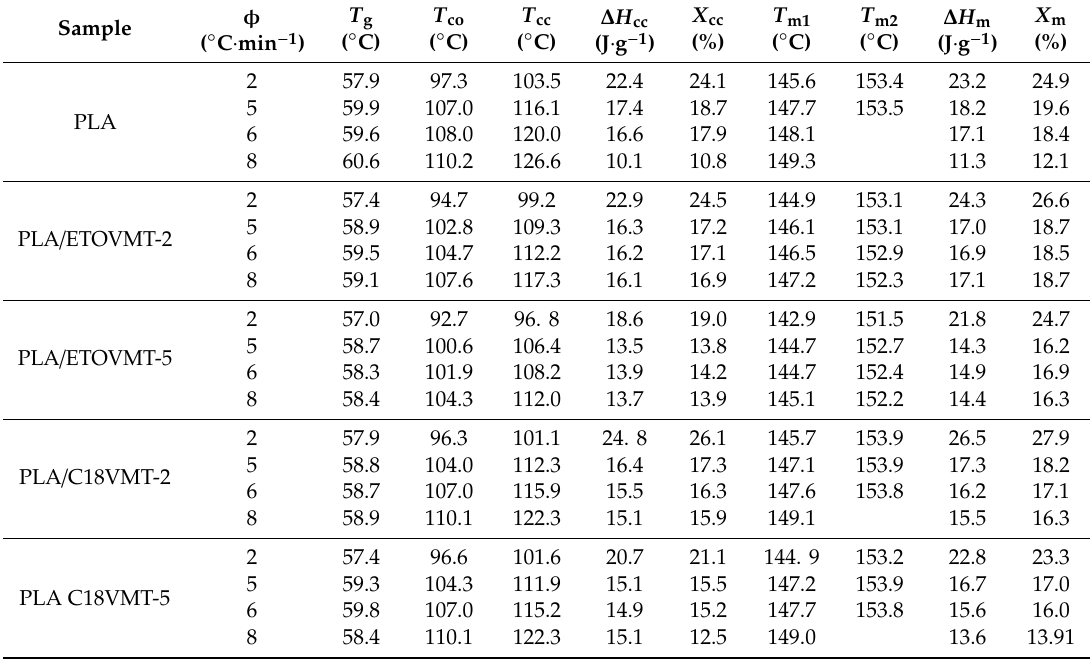
Table 2. DSC results derived from the second heating scan for pure PLA and PLA / VMTs.